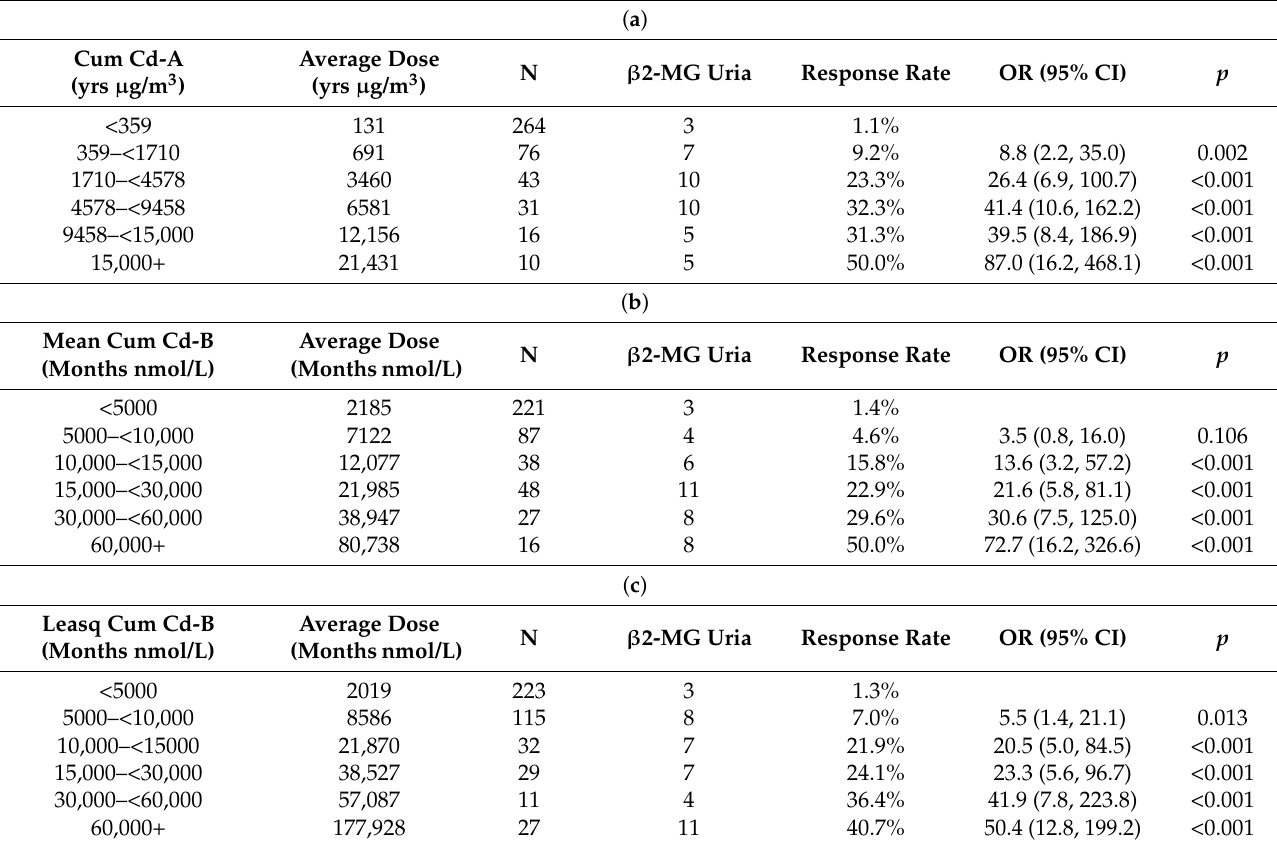
Table 2. ( a ) Dose–response relationship using cumulative air-cadmium as the dose-indicator. ( b ) Dose–response relationship using mean cumulative blood-cadmium as the dose-indicator. ( c ) Dose–response relationship using cumulative blood- cadmium as the dose-indicator (least-squares estimate).